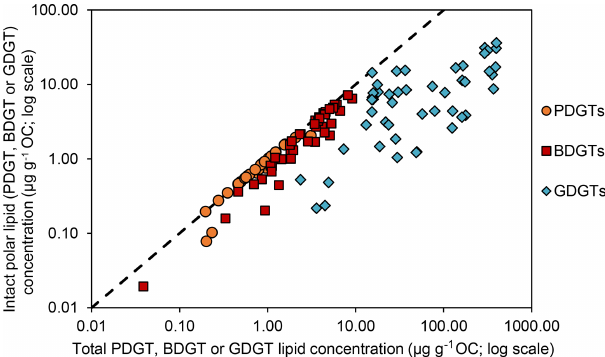
Figure 3. Intact polar lipid concentration against total lipid con- centration (log scales) for each archaeal lipid type discussed in this study (PDGTs in orange, BDGTs in red and GDGTs in blue). The dashed line represents the 1:1